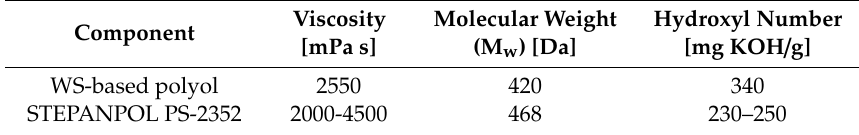
Table 2. Selected properties of polyester polyol and walnut shell (WS)-based polyol [11].